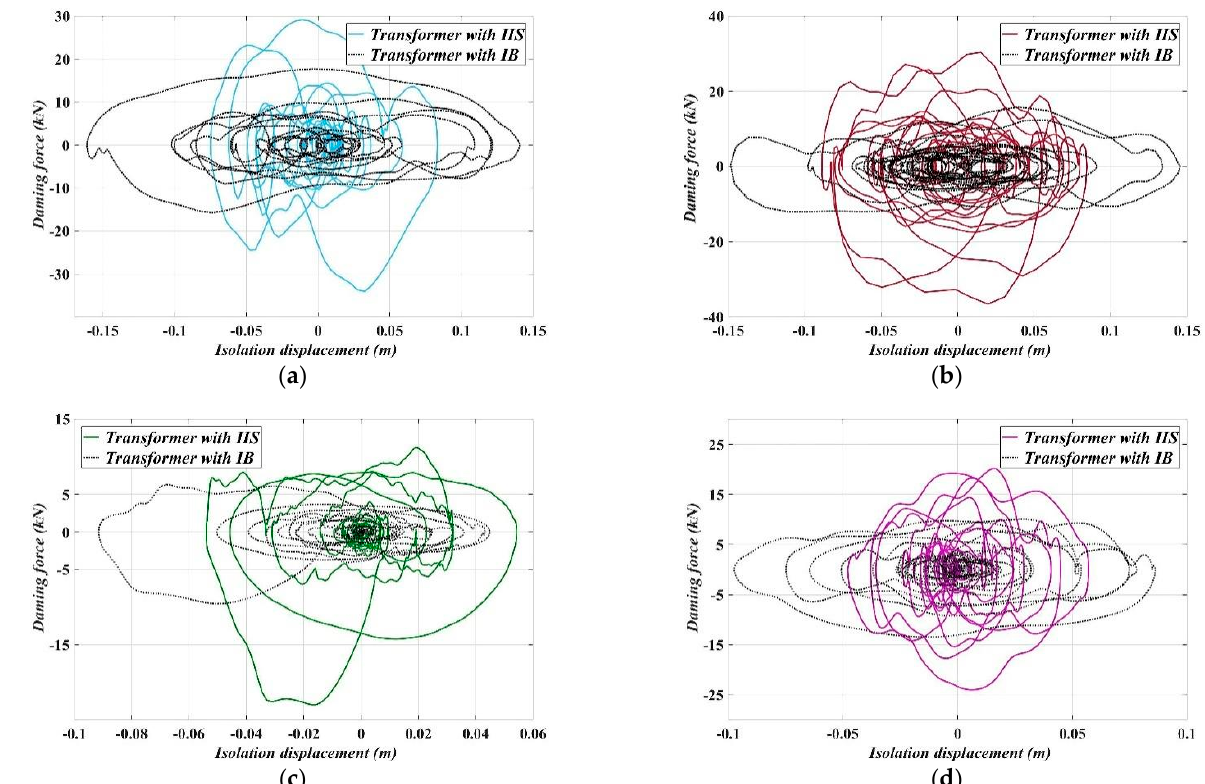
Figure 18. Hysteresis loops of isolation layer (LB – 2): ( a ) EL Centro; ( b ) Taft; ( c ) Chi–Chi; ( d ) Kobe.